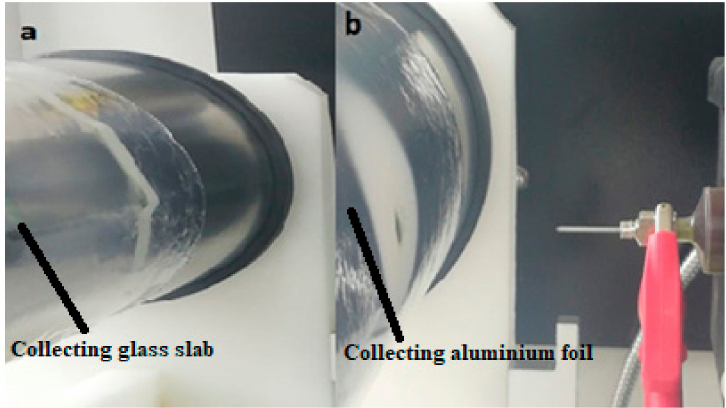
Figure 3. ( a ) Glass holder to collect samples for microscopes ( b ) for SEM